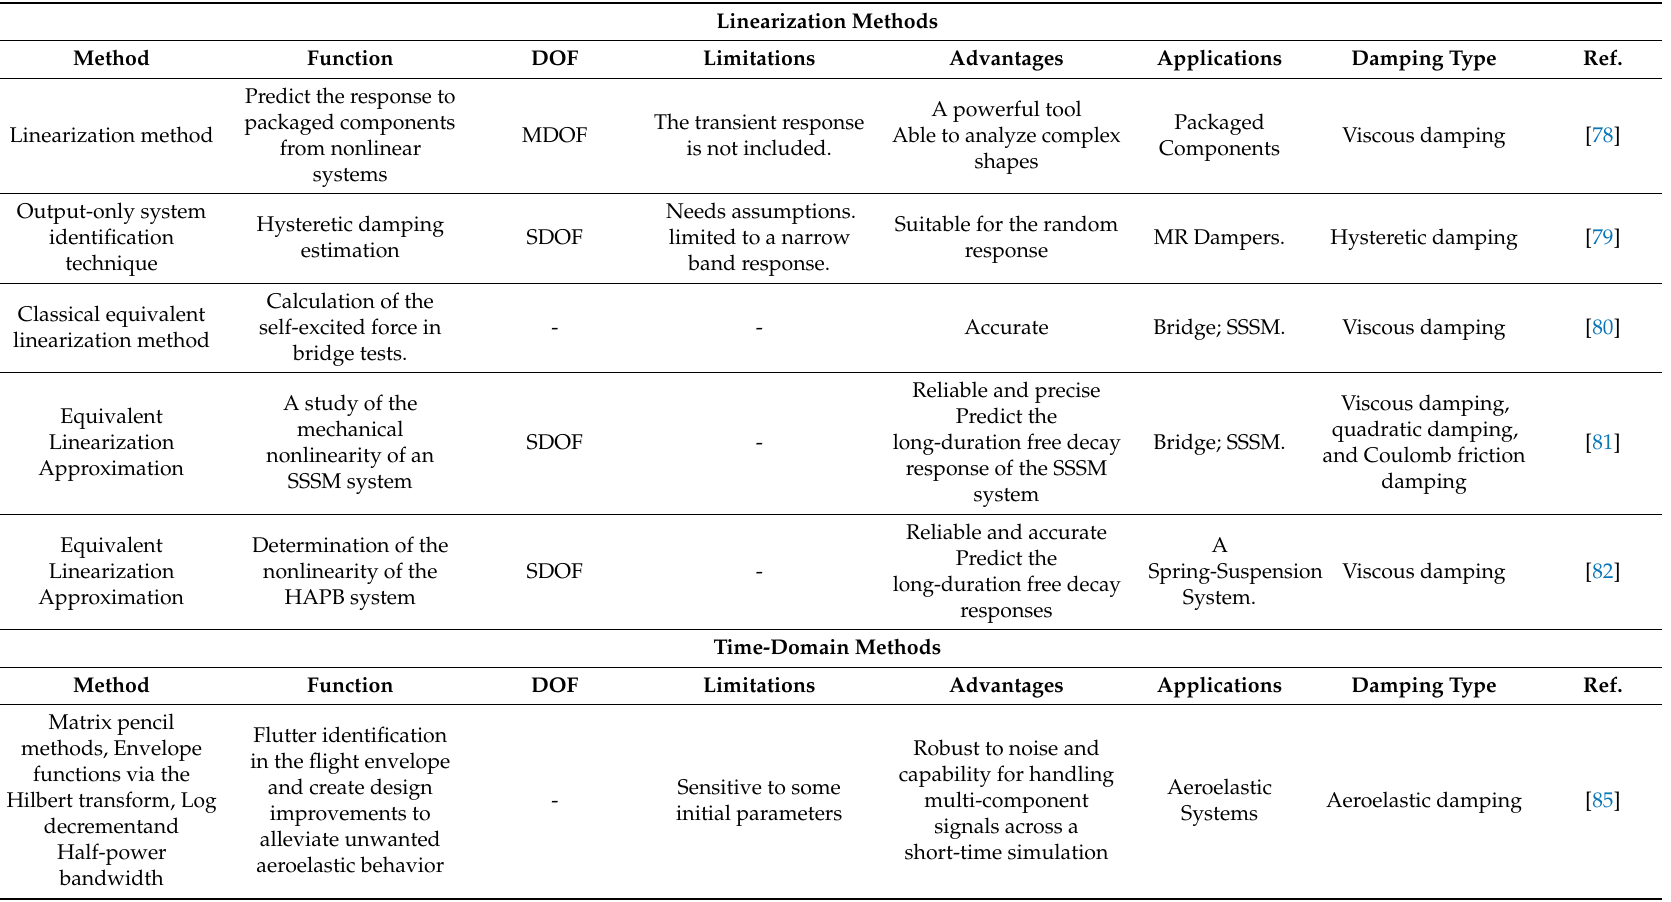
Table 1. Literature survey of nonlinear damping identification